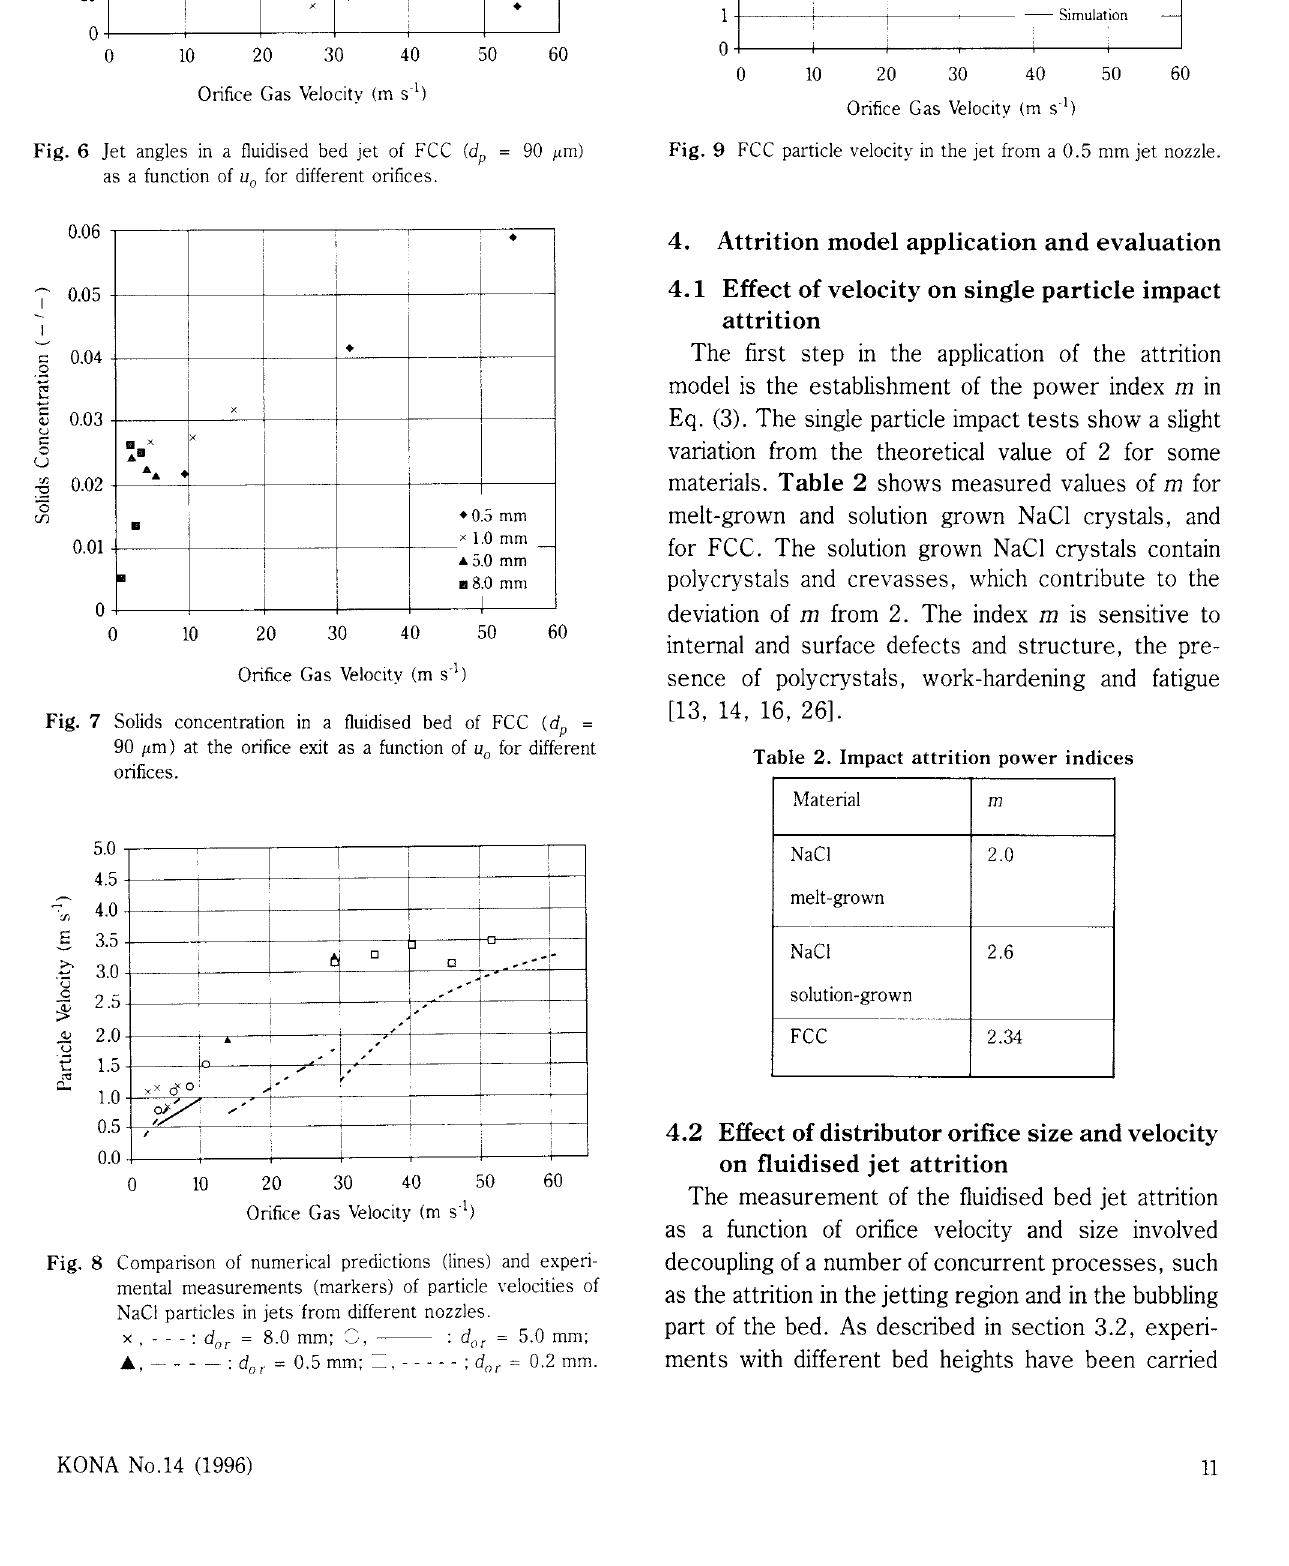
KONA No.14 (1996)